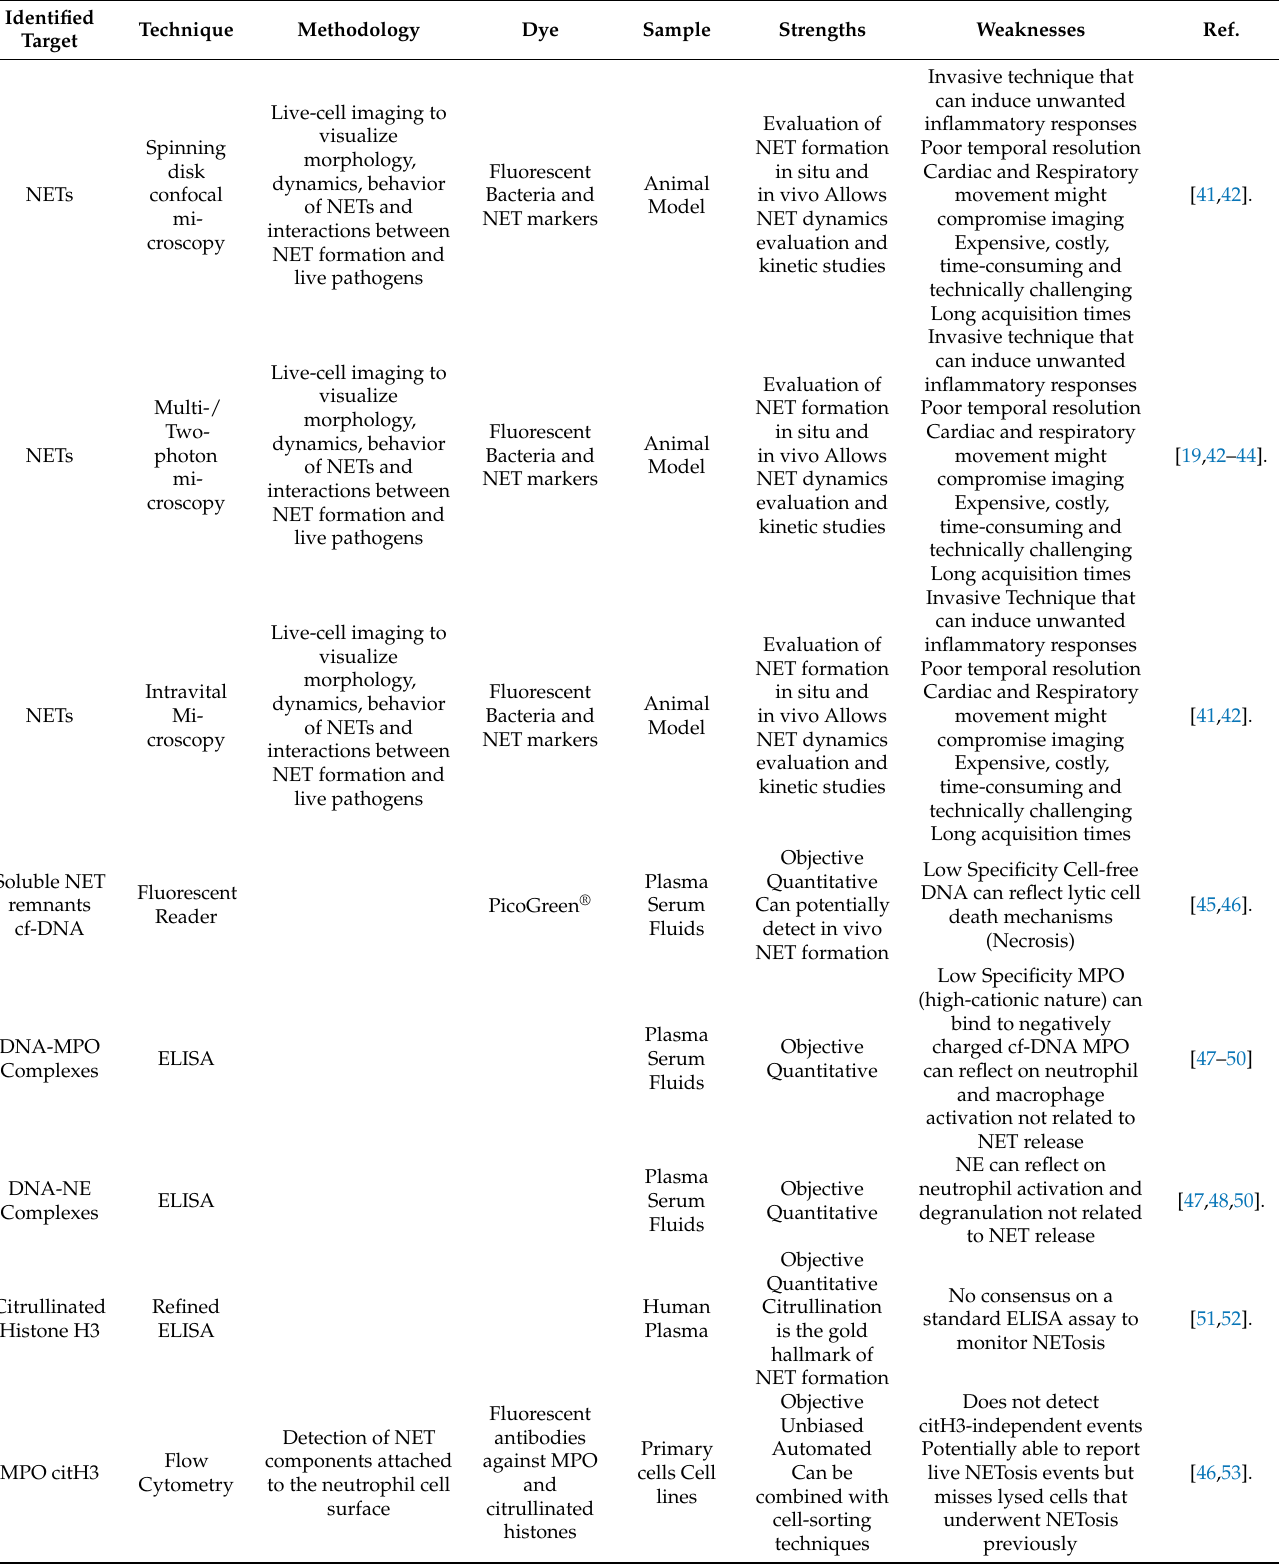
Table 1. NET Visualization